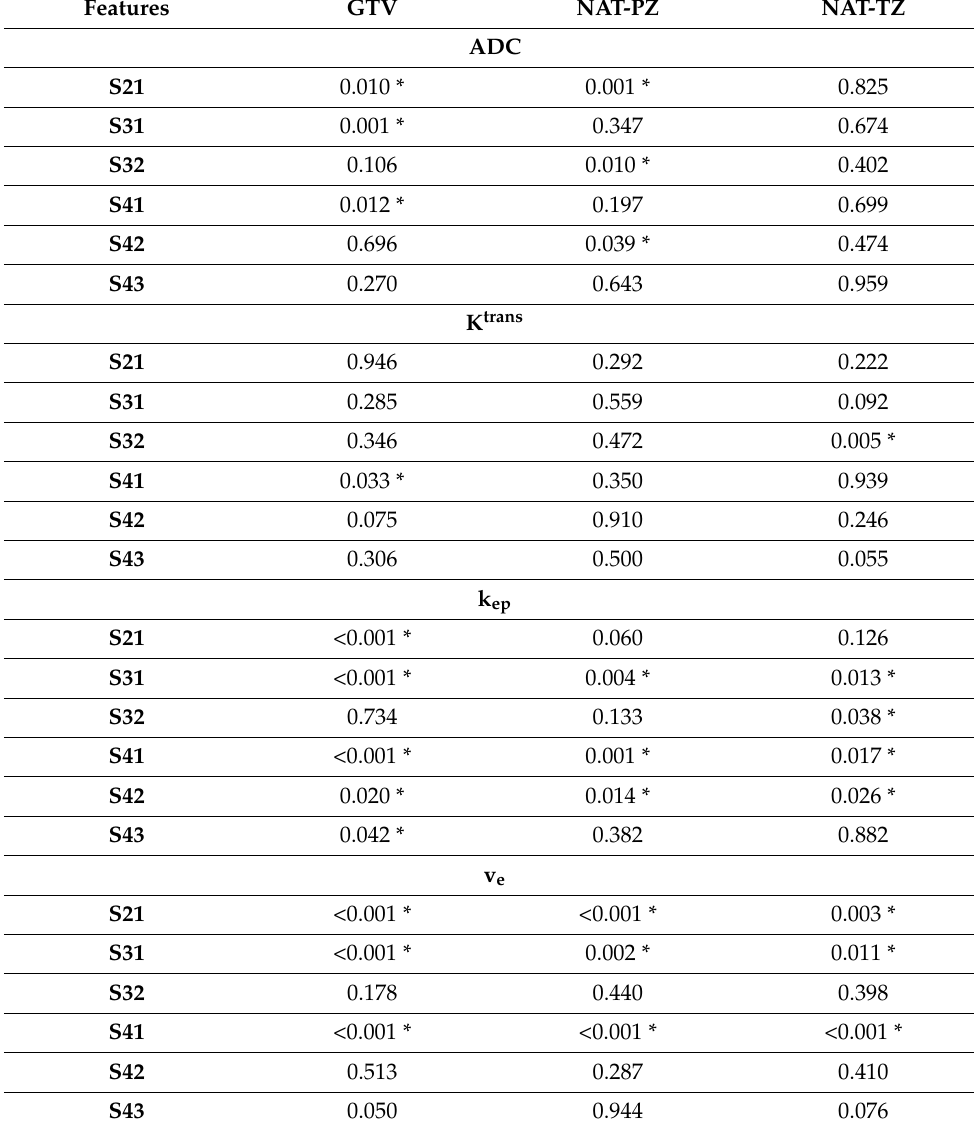
Table A3. Comparison of quantitative imaging features at baseline. The p -values from Student’s t-test between ROIs are reported. Statistically significant values (<0.05) are marked with